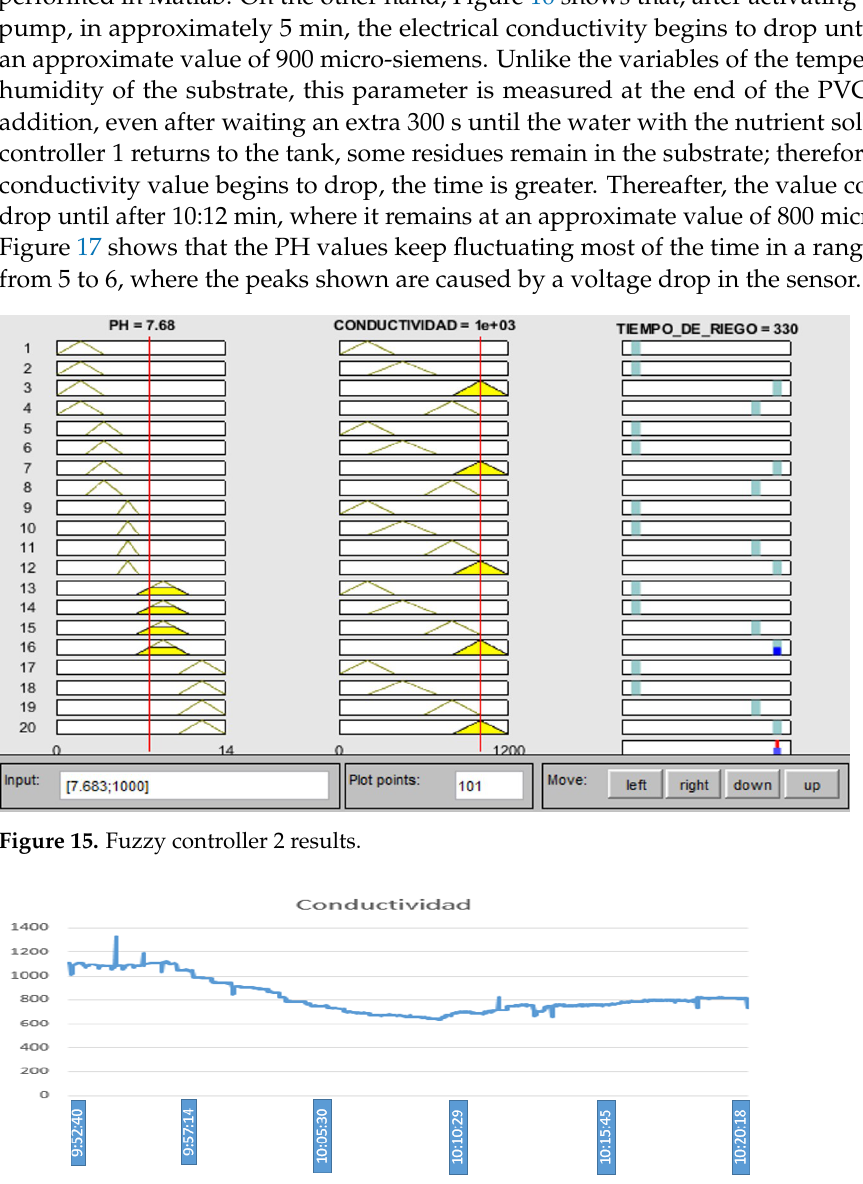
Figure 16. Nutrient substance Electrical